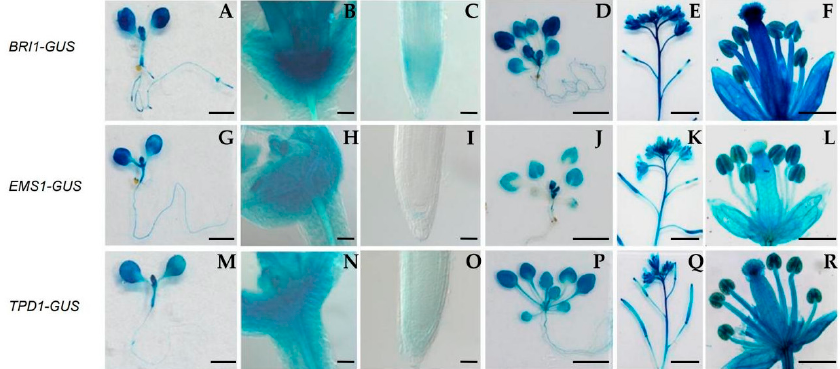
Figure 6. The expression of BRI1 , EMS1 , and TPD1 . ( A – F ) BRI1::GUS ; ( G – L ) EMS1::GUS ; ( M – R ) TPD1::GUS . From left to right, each small panel represents a seedling 8 days after germination (DAG), a shoot tip from an 8-DAG seedling, a root tip from an 8-DAG seedling, a seedling of 25- DAG, an inflorescence from a 45-DAG plant, and a mature flower from a 45-DAG plant, respec- tively. Scale bars: ( A , G , M ) 1 mm; ( B , H , N ) 50 μ m; ( C , I , O ) 50 μ m; ( D , J , P ) 0.5 cm; ( E , K , Q ) 0.5 cm; ( F , L , R ) 1 mm. Receptor-like kinases (RLK) are the largest receptor family in plants. With the evolu-